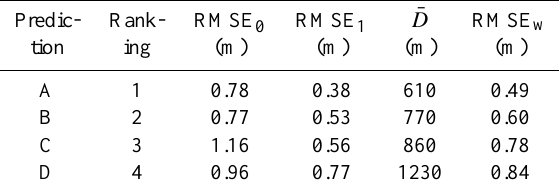
Table 2. Subjective ranking (with 1 being the best prediction) and errors for competing predictions, generated with Delft3D for vari- ous boundary conditions. The “observations” are taken as the model outcome at 0 ◦ (cf. Sect. 3.1). The values for RMSE w hold for D max =